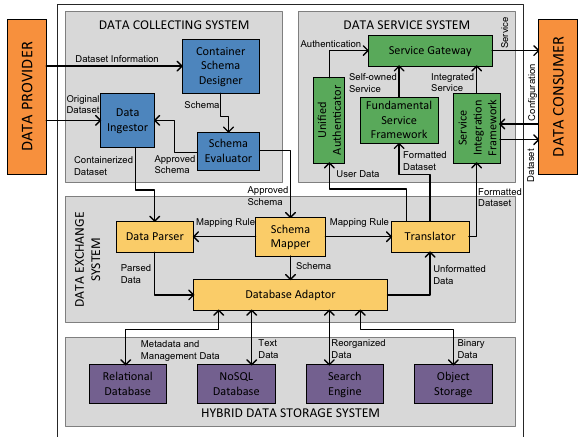
Fig. 1 Overall architecture of MGED. The architecture of MGED consists of four main systems: DCS, DES, HDSS, and DSS. DCS is responsible for collecting original datasets from multiple data providers and normalizing them into standard container format. DES manages data mapping rules and performs data transformation among different formats. HDSS stores each category of data into the corresponding database. DSS provides various data services through the fundamental services framework and the service integration